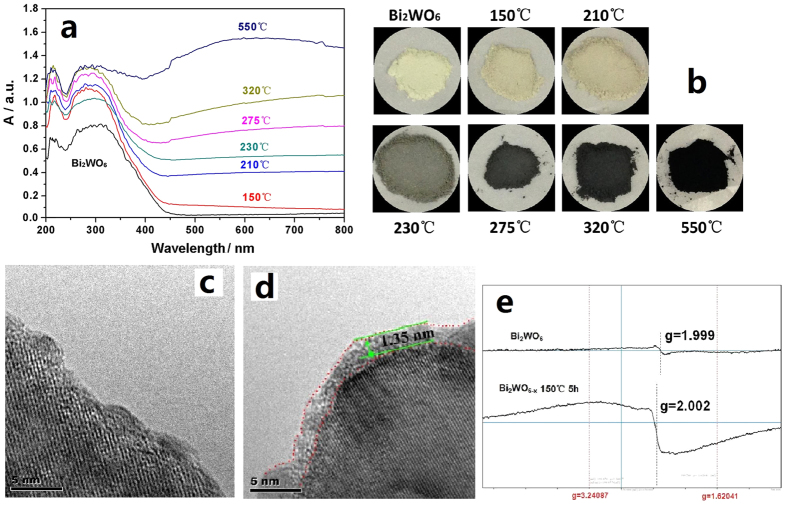
(a,b) UV–DRS and the photoes of Bi2WO6 and Bi2WO6−x samples; (c,d) The HR–TEM of Bi2WO6 and Bi2WO6−x (150 °C for 5 h); (e) In situ EPR spectra of Bi2WO6 and Bi2WO6−x (150 °C for 5 h), at 77 K.